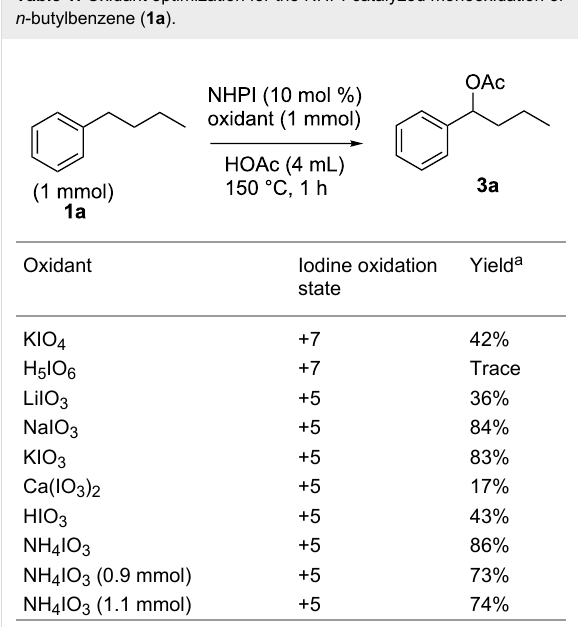
Table 1: Oxidant optimization for the NHPI-catalyzed monooxidation of n -butylbenzene ( 1a ).